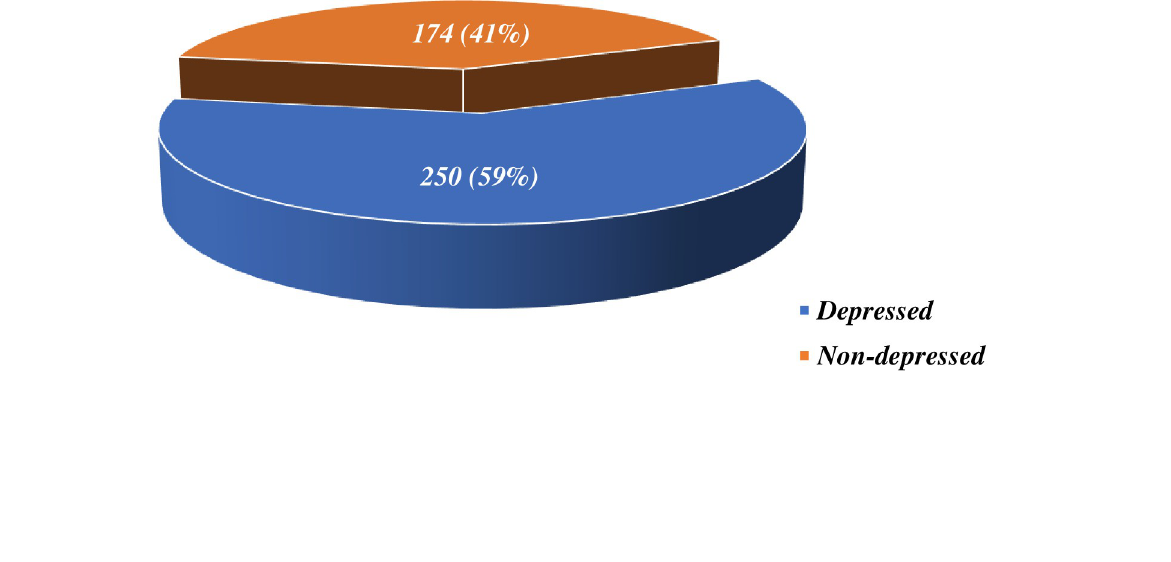
Fig 3. Prevalence of depression among heart failure patients attending cardiac follow-up clinic at selected government specialized teaching hospitals in Addis Ababa, Ethiopia (n = 424).